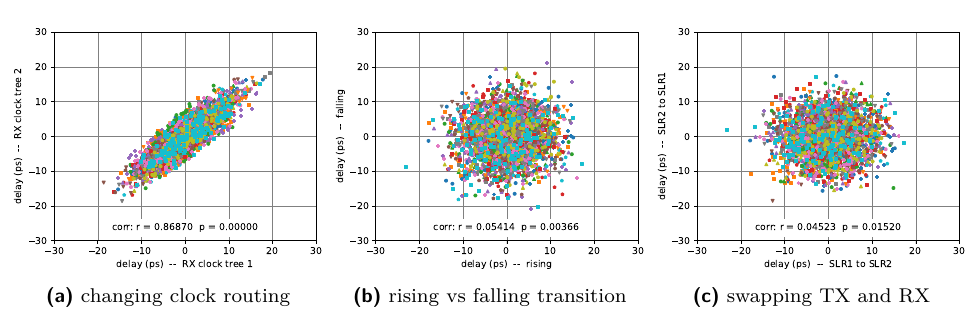
Figure 13: Scatterplot shows correlations between the PUF outputs for (a) the case where clock routing is changed; (b) where a rising transition is replaced by a falling one; and (c) where the direction of the propagating signal is